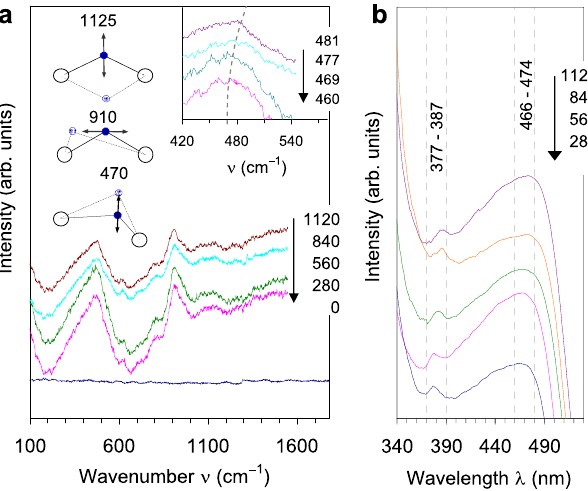
Fig. 2 Optical spectra of the implanted samples. a Raman scattering spectra with assignments for the 3 A 1g modes; the inset shows the red shifts of the peaks at 460 cm − 1 . b UV-Vis absorption